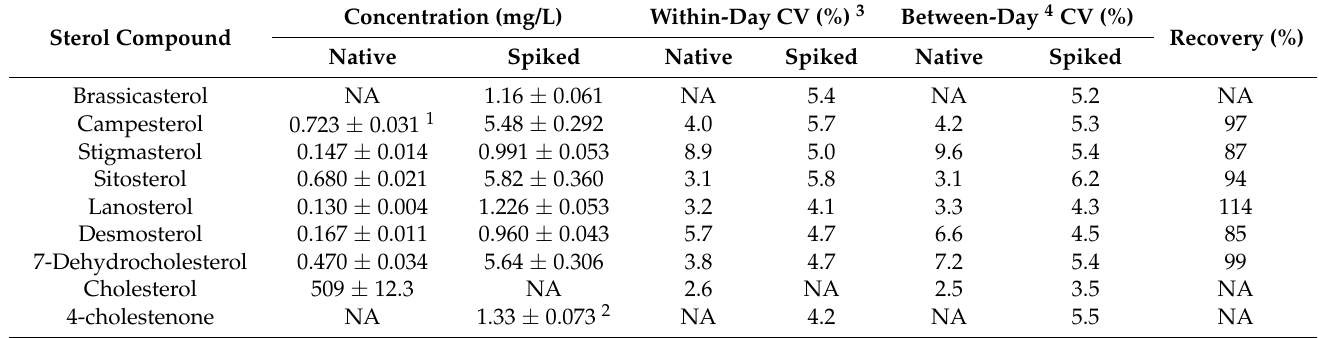
Table 2. Reproducibility and recovery assessment ( n = 5) in native and spiked EDTA plasma